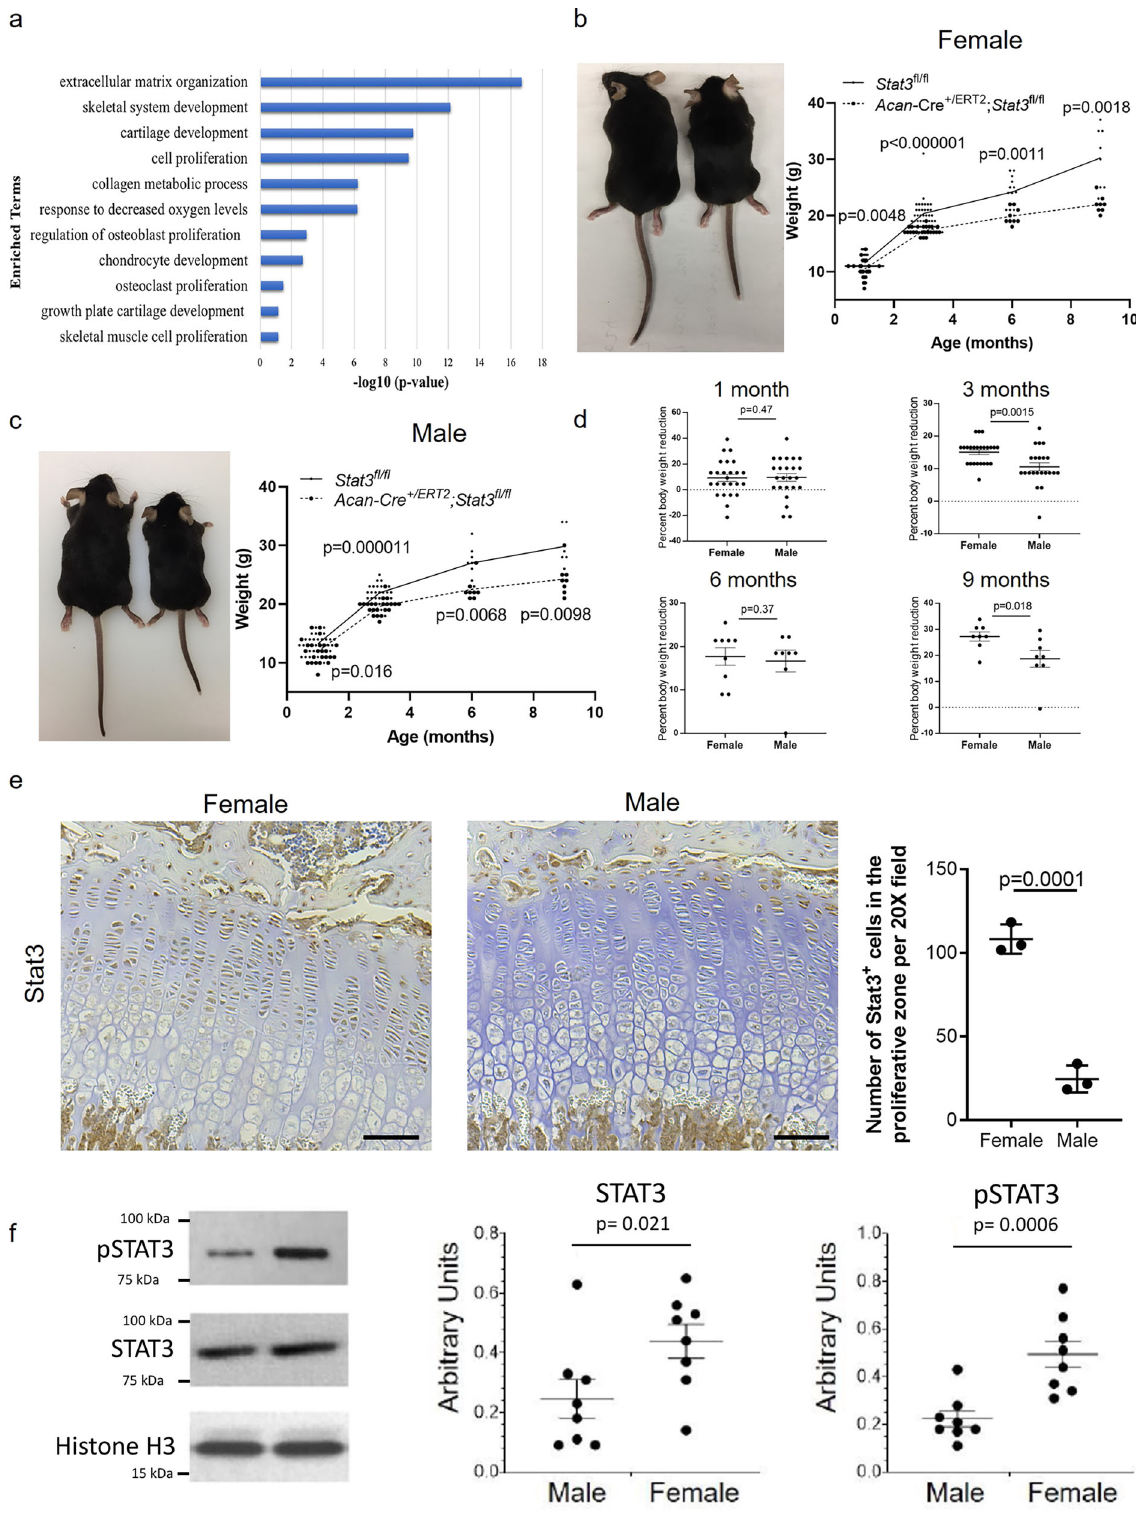
Fig. 1 STAT3 regulates anabolic genes in human fetal chondrocytes and body size in mice. a Altered gene expression in human fetal chondrocytes after knockdown of STAT3 by shRNA in vitro as determined by bulk RNA-Seq and GO analysis; n = 3. Postnatal deletion of Stat3 in chondrocytes via Acan -Cre + /ERT2 in vivo decreases body weight and size of female ( b ) and male ( c ) mice; n ≥ 7 for each sex and genotype per timepoint. Images of 6 month old mice are shown. d Reductions in body weight in Stat3 mutants compared to WT littermates were greater in female than in male mice. e Stat3 protein localized to the resting and proliferative zones of the growth plate at 1 month in WT mice. f Stat3 and pStat3 levels were higher in WT female mice as compared to WT male mice ( n = 8). Scale bars = 50 µ